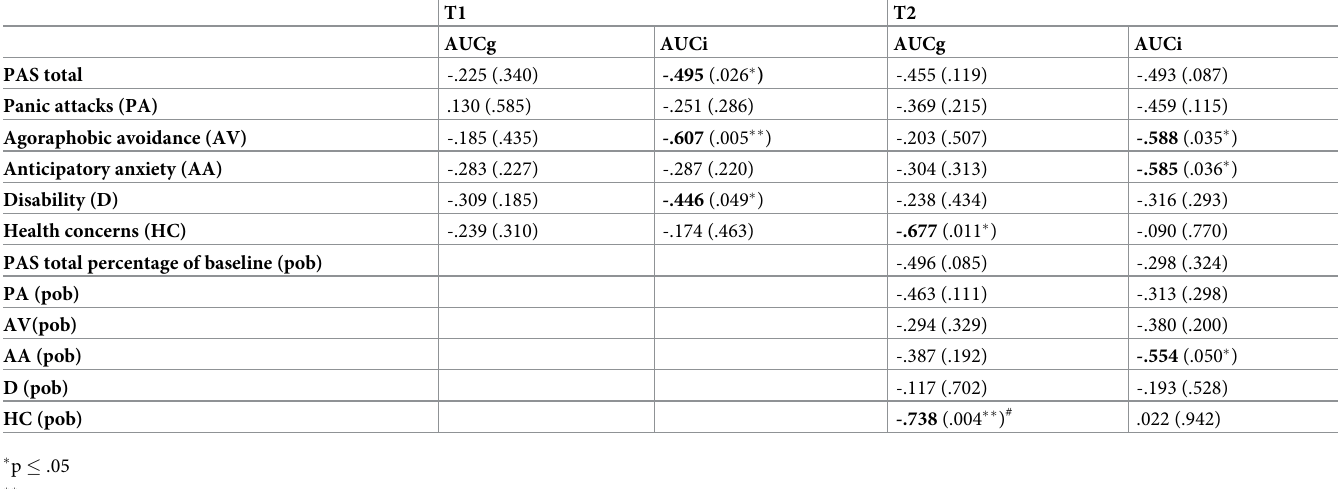
Table 2. Spearman´s correlations between cortisol response under Low Intensity Exercise (LIE) (AUCg/ AUCi) and the PAS score at T1 (n = 20), T2 (n = 13) and percent change in PAS from T1 to